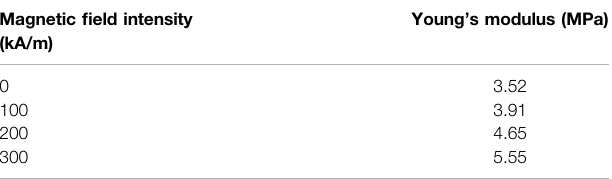
TABLE 1 | Young ’ s modulus for various magnetically controlled fi lms produced under the same prestressing from different magnetic fi eld strengths. Magnetic fi eld intensity (kA/m)